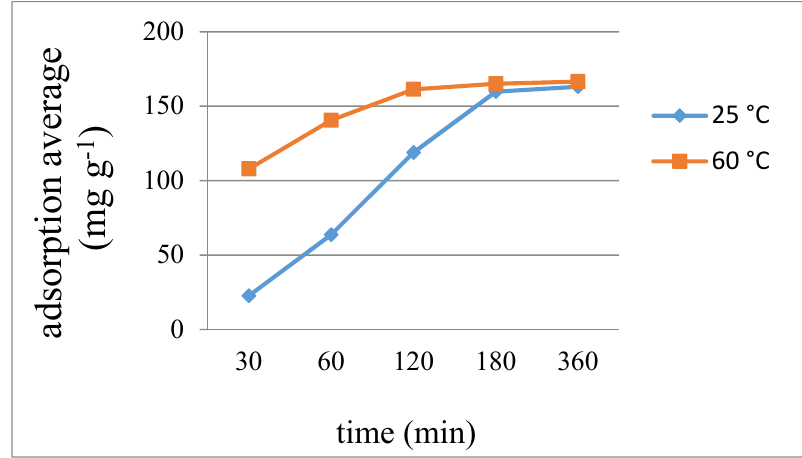
Figure 11. Average weight changes of complex 9 upon iodine adsorption.